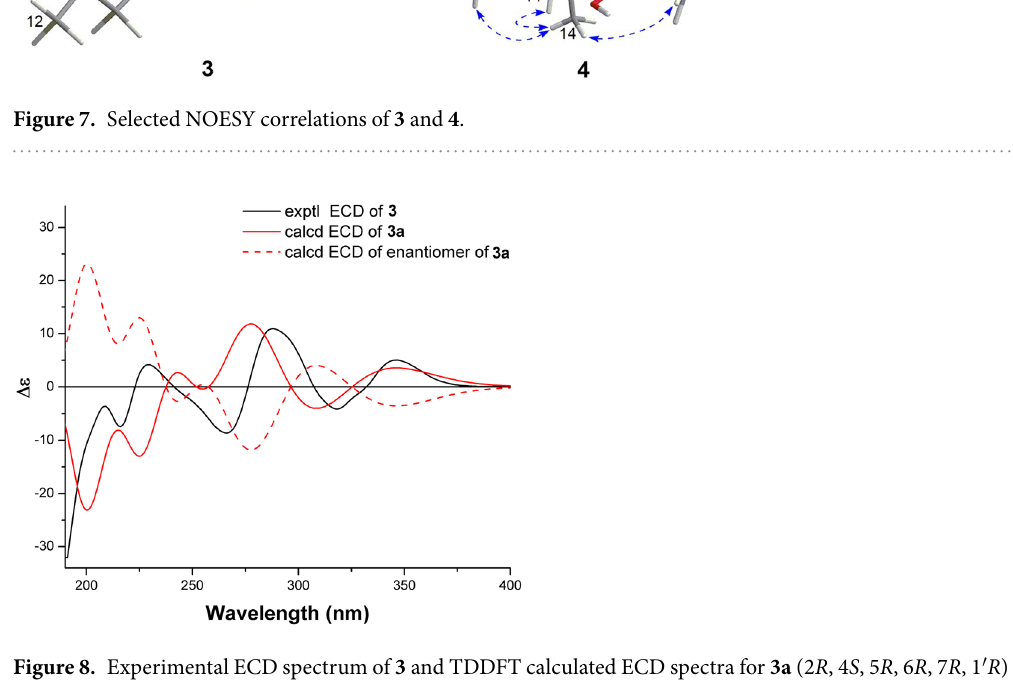
Figure 8. Experimental ECD spectrum of 3 and TDDFT calculated ECD spectra for 3a (2 R , 4 S , 5 R , 6 R , 7 R , 1 ′ R ) and enantiomer of 3a